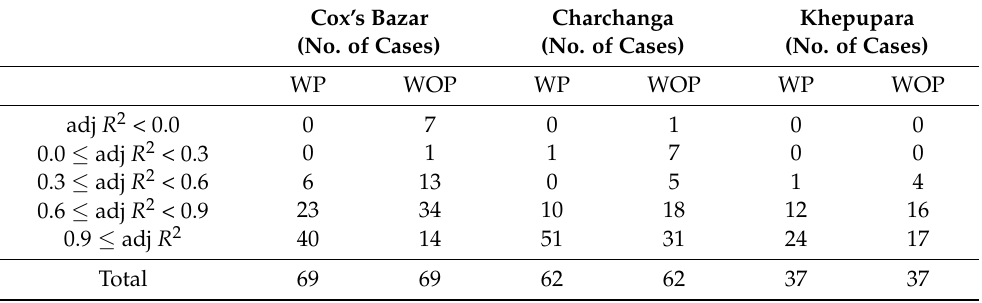
Table 3. The adjusted R 2 for predictions with precipitation (WP) and without precipitation (WOP). Cox’s Bazar Charchanga (No. of Cases) (No. of Cases)